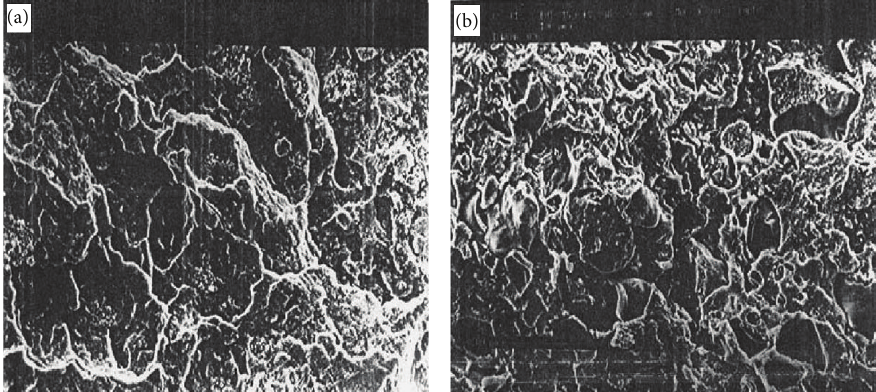
Figure21:SEMmicrographsoftensilefracturesurfaceof(a)40/0and(b)20/20silica/WRHA(wt/wt)ofPP/silica/WRHAhybridcomposites, respectively (mag. × 300)